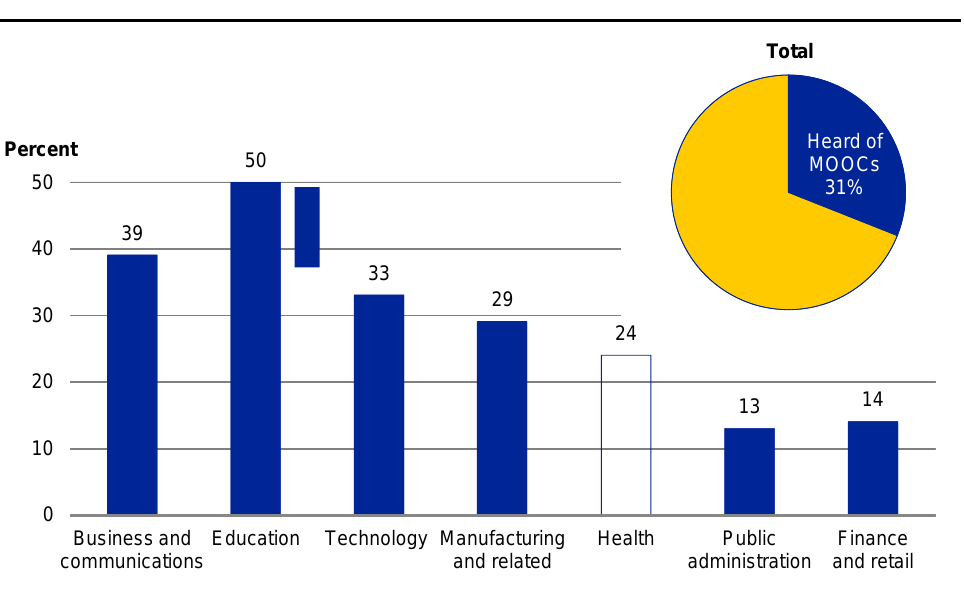
Figure 3. Percentage of organizations that had heard of MOOCs: among all respondents and by